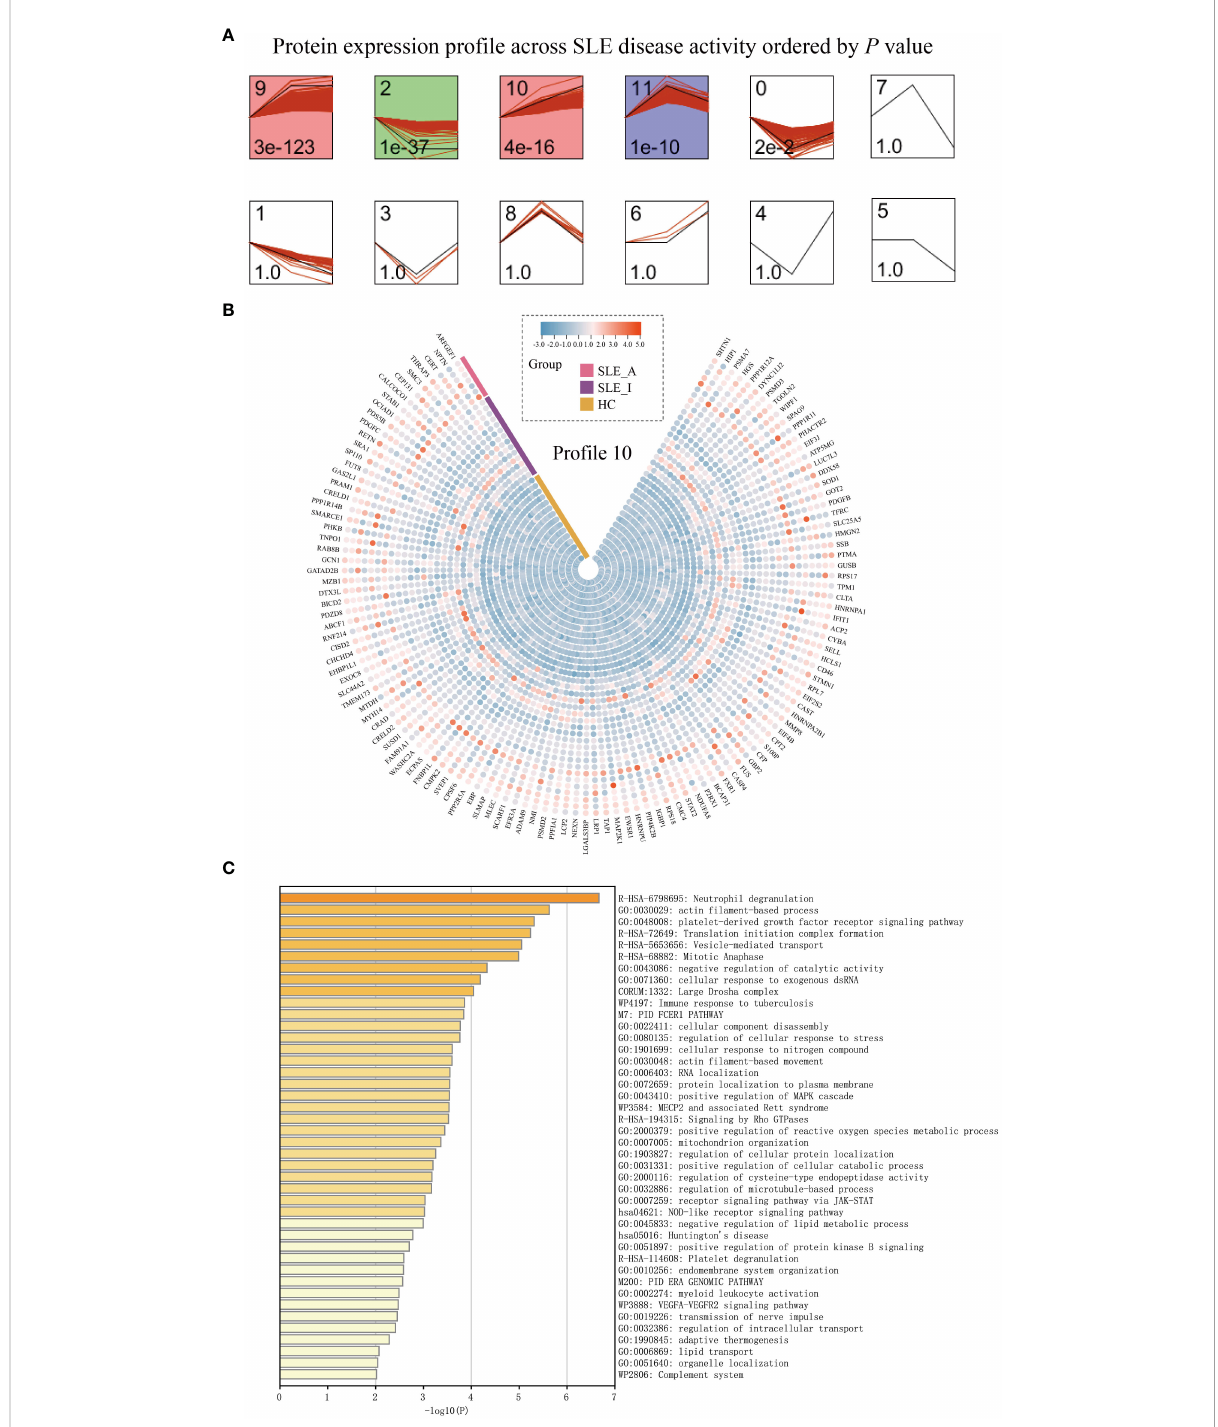
FIGURE 3 PBMC proteomic data for SLE disease exacerbation. (A) PBMC proteomics pro fi les of STEM analysis. STEM analysis was applied to obtain the protein expression pro fi les across HC, SLE_I, and SLE_A. Pro fi le ID was shown at the top left corner of the pro fi le, and signi fi cance ( P value) was shown at the bottom left corner of the pro fi le. Red lines in each pro fi le represent the expression pattern of proteins across HC, SLE_I, and SLE_A (permutation test, P < 0.05). (B) Heatmap for the expression of proteins in pro fi le 10 along with disease exacerbation. (C) The function analysis of pro fi le 10 in Metascape platform ( P <